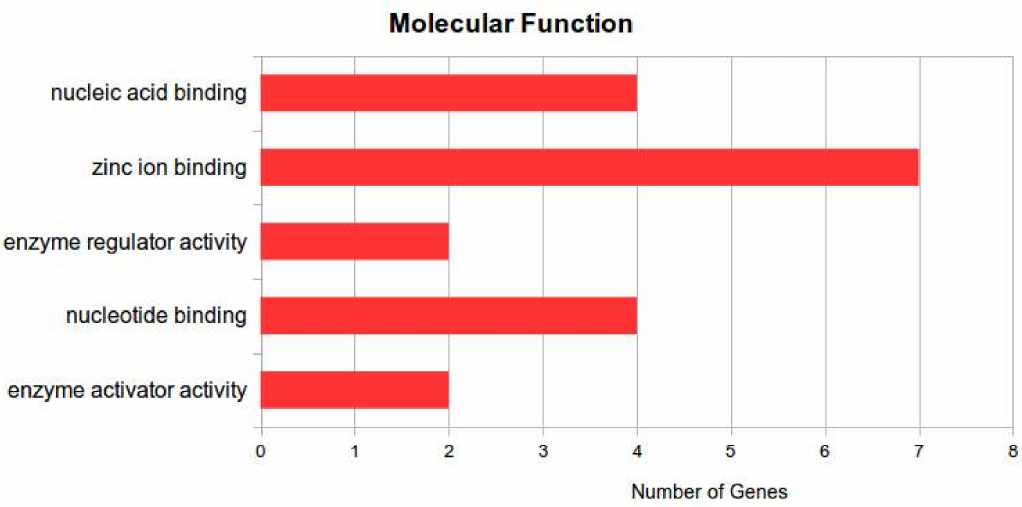
Figure 7. Genes involved in nucleic acid binding, zinc ion binding, enzyme regulator activity, nucleotide binding, and enzyme activator